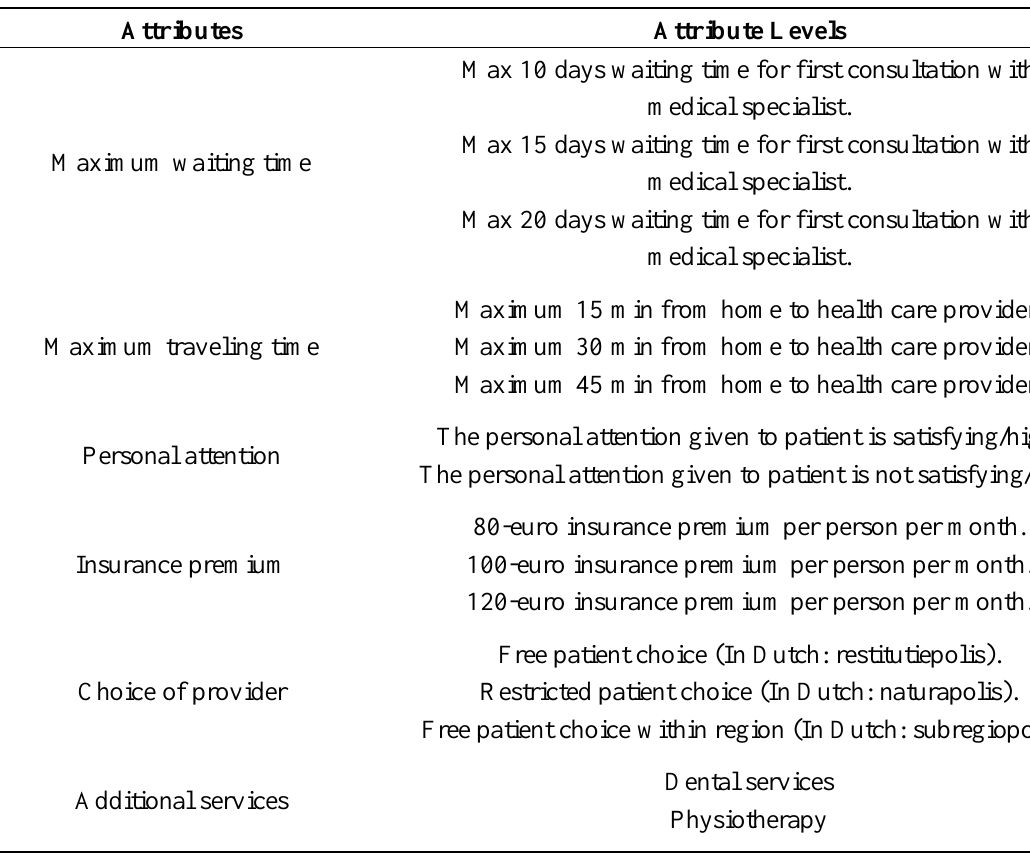
Table 1. Attributes and their